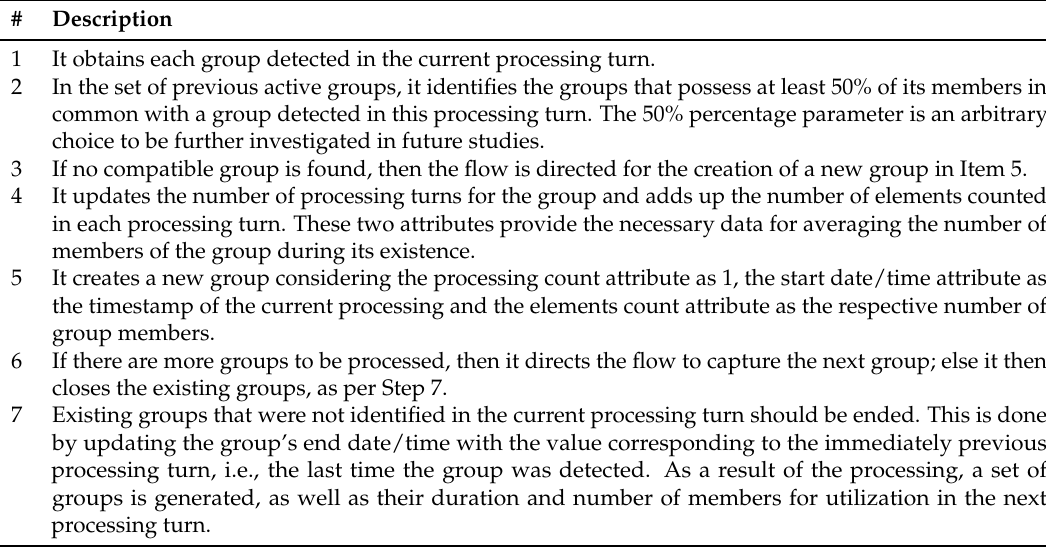
Table 10. Algorithm 3 specification (group risk indicators).